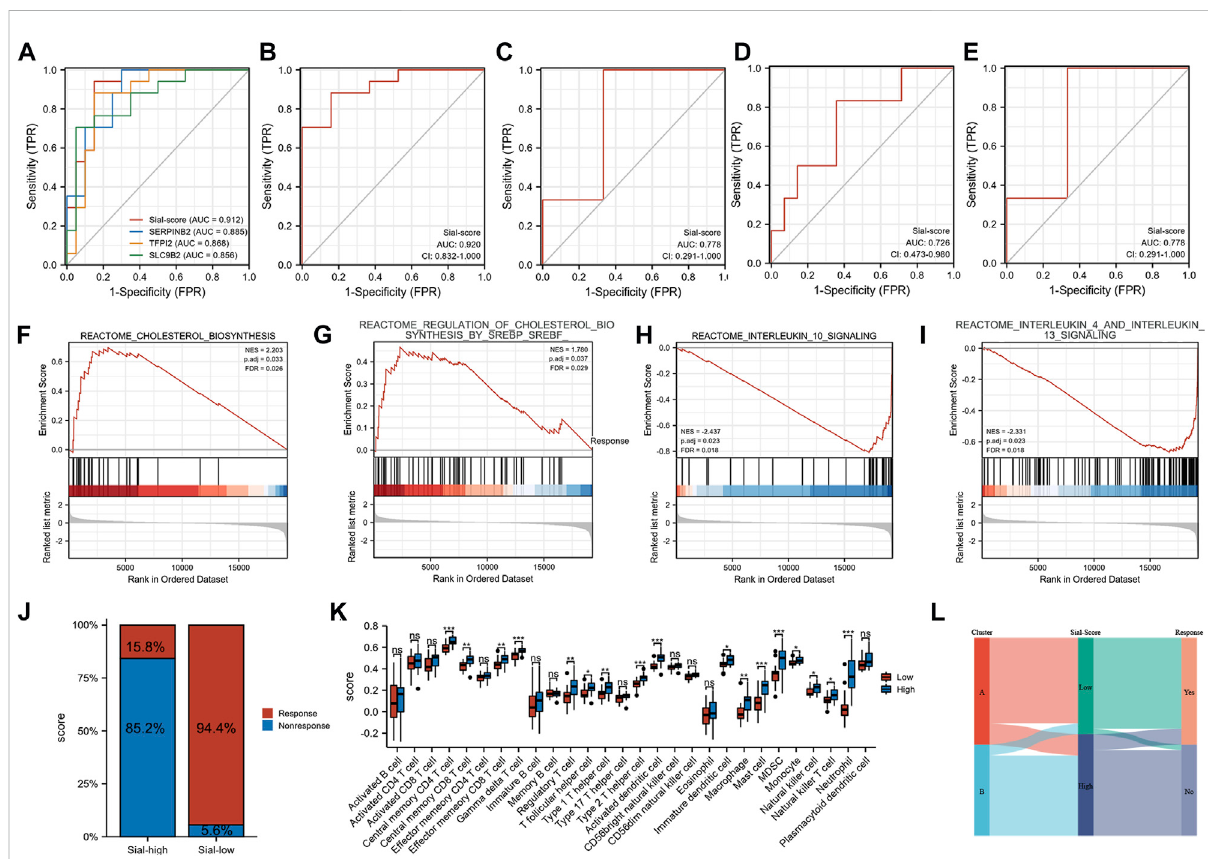
Construction of the Sial-score. (A) ROC of the Sial-score and selected biomarkers to distinguish responders and non-responders before treatment in GSE16879 cohort. (B) ROC of the Sial-score to distinguish responders and non-responders after treatment in GSE16879 cohort. (C – E) ROCoftheSial-scoretodistinguishrespondersandnon-respondersinvalidationcohortsGSE111761,GSE42296,andGSE107865,respectively. (F – I) GSEA enrichment in Sial-low group. (F,G) GSEA enrichment in Sial-high group. (J) Stacked bar plot of percentage of response and non- response patients in Sial-high and Sial-low groups. (K) In fi ltration fraction of immune cells in Sial-high and Sial-low groups (L) Alluvial diagram of subtype distributions in groups with different Sial-scores and outcomes of anti-TNF therapy response. (* p < 0.05, ** p < 0.01, *** p < 0.001; ns, not signi fi